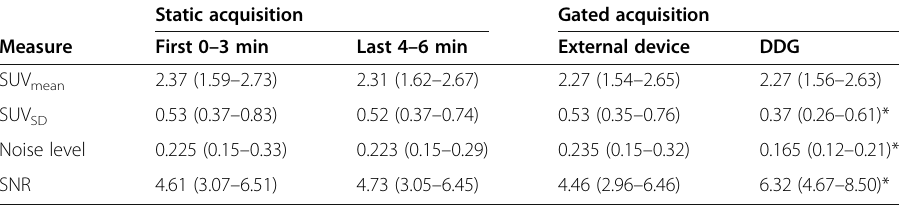
Table 1 Quantitative measures in a liver sphere with a diameter of 3 cm. Data represents mean value and range (* indicates significantly different value, p <0.01, for DDG compared with either